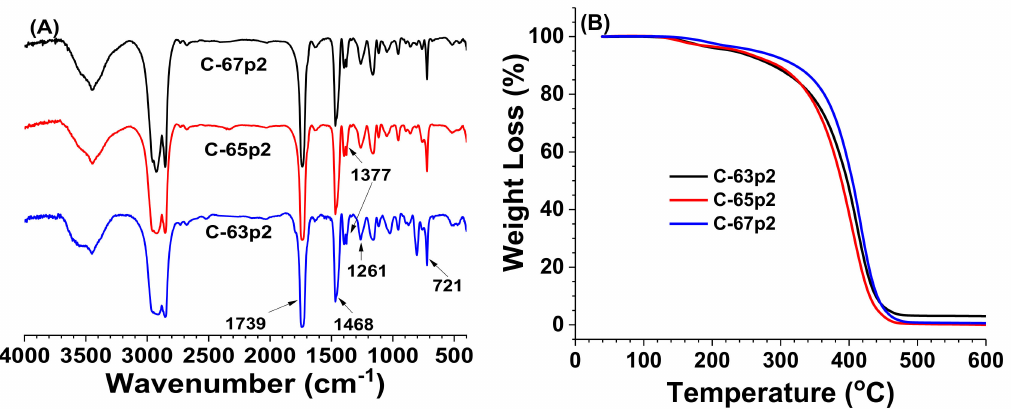
Figure 1. Fourier transform infrared (FTIR) spectra ( A ) and thermo-gravimetric analysis (TGA) thermograms ( B ) of C-63p2, C-65p2 and C-67p2